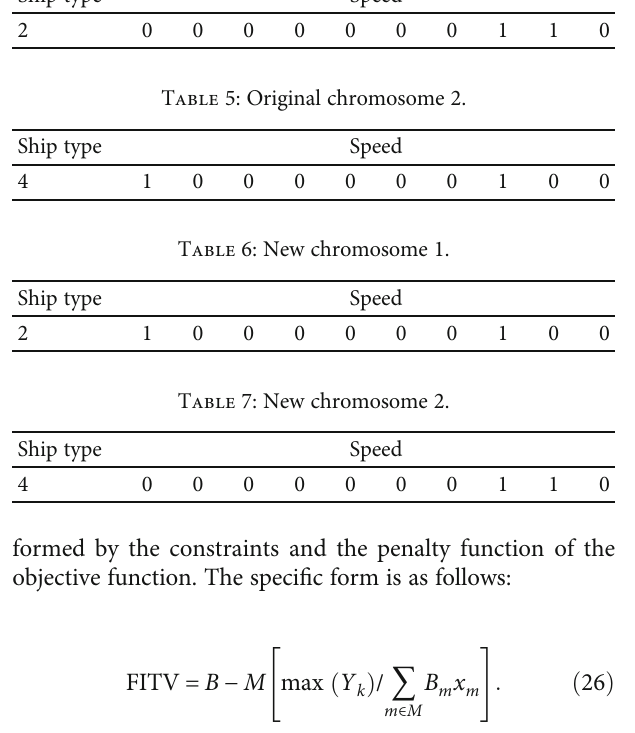
Table 2: The cargo transportation volume between ports, q